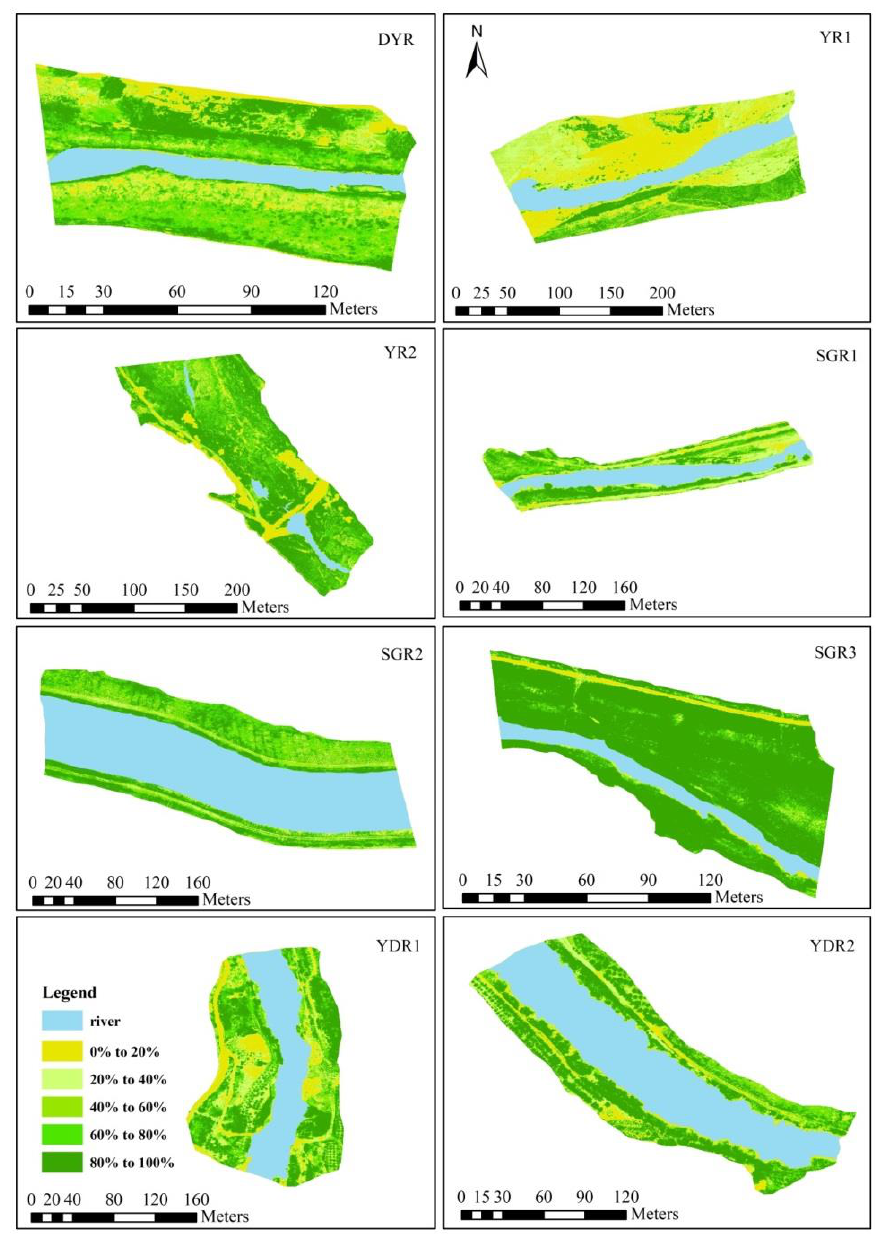
Figure 4. Vegetation coverage of the riparian zones of the eight selected reaches (0 – 20%: extremely low; 20 – 40%: low; 40 – 60%: medium; 60 – 80%: high; 80 – 100%: extremely high).